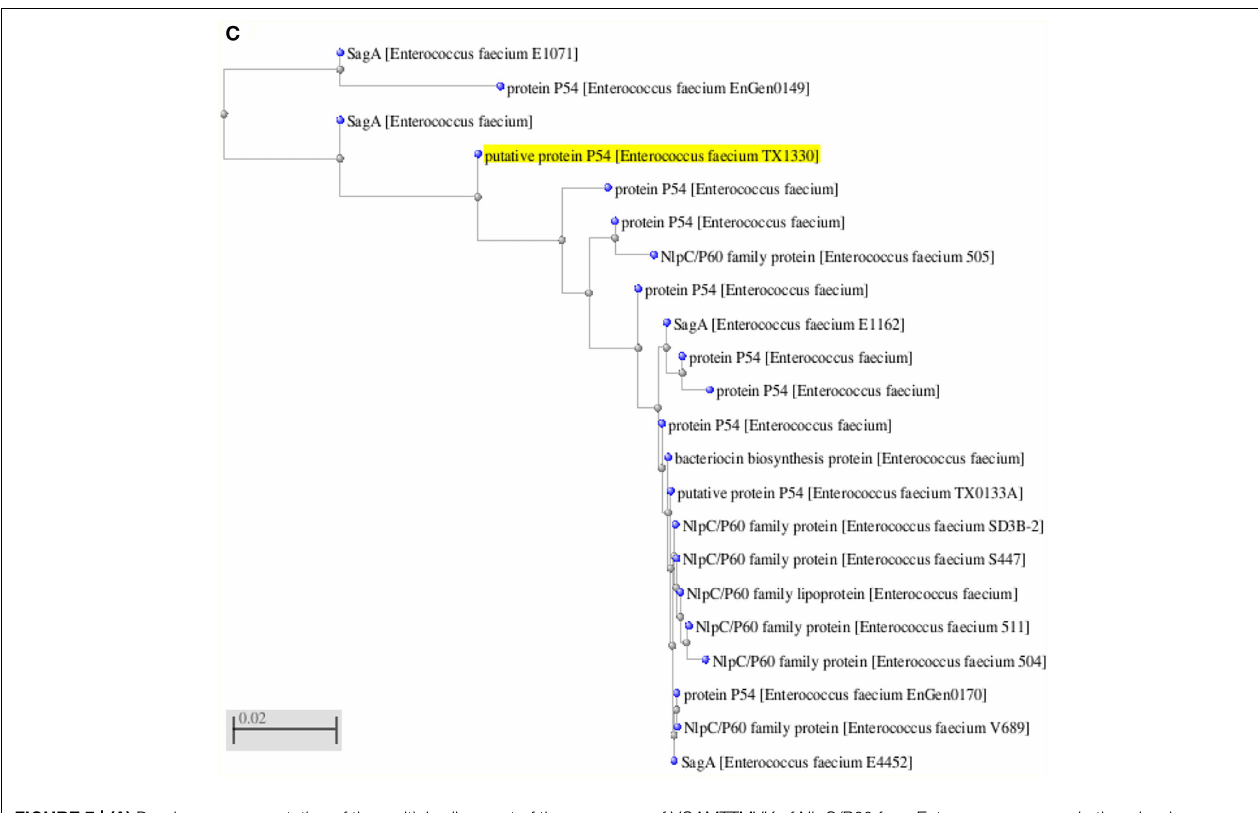
of VQAMTTMVK of NlpC/P60 from Enterococcus sp. and other closely related strains. (C) Dendrogram presentation of the multiple alignment of the deduced amino acid sequence of DIADLQER of NlpC/P60 from Enterococcus sp. and other closely related